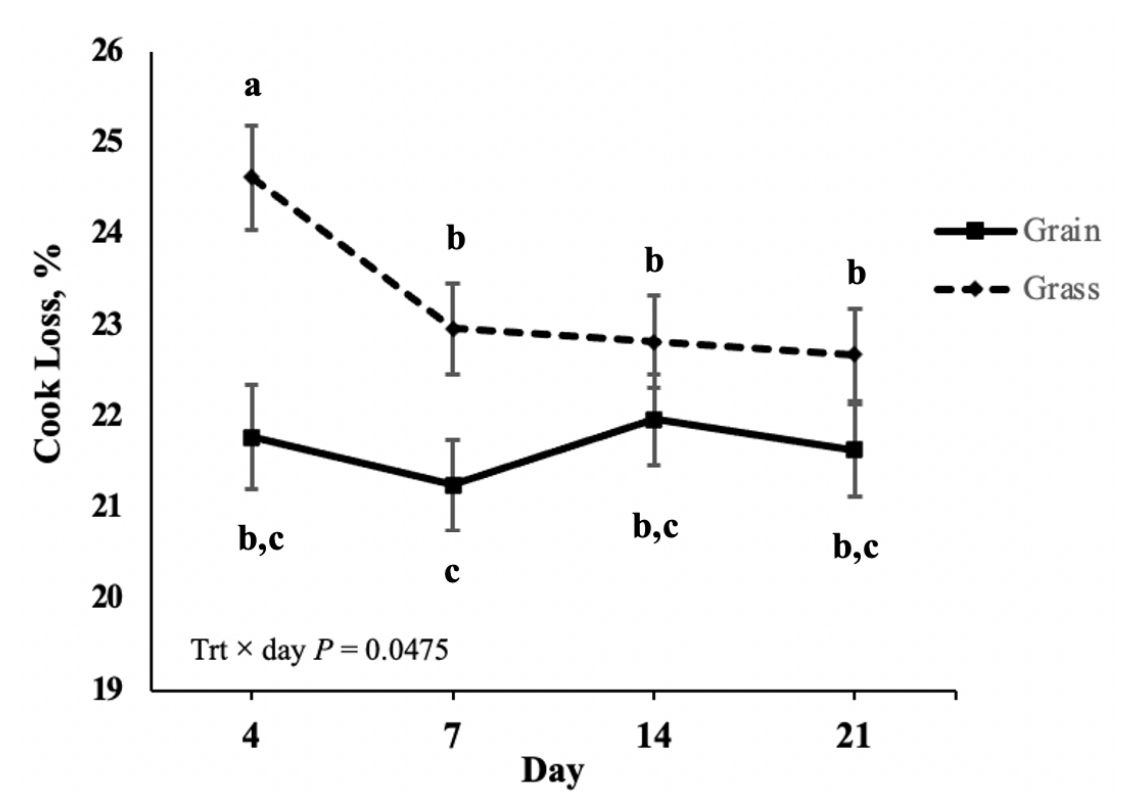
Figure 3. Least square means for the interaction of postmortem aging days and finishing system on cook loss of bison striploin steaks . Treatments: GRAIN = bison heifers backgrounded on pasture and finished for 130 days with ad libitum access to grass hay, alfalfa, and a corn and dry distiller’s grain concentrate prior to slaughter. GRASS = bison heifers remained on pasture until slaughter. All steaks were stored frozen prior to analysis. a,b,c Means lacking a common superscript differ p <